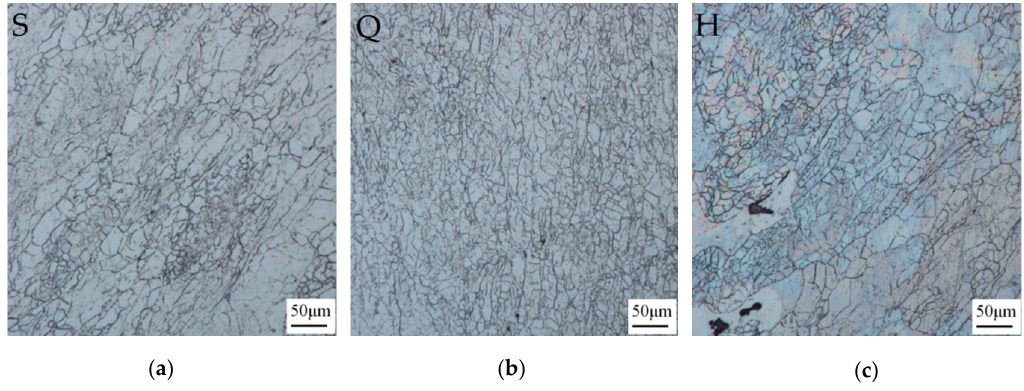
Figure 5. Microstructures of hot rolled aluminum alloy 7050 plate. ( a ) Top surface; ( b ) 1 / 4 layer; ( c ) 1 / 2 layer. The distribution of temperature and equivalent strain at di ff erent layer of the plate during the hot rolling process was also plotted, as shown in Figure 6. The horizontal axis represents the time from initial change in temperature or equivalent strain until it reaches a steady state. Because the